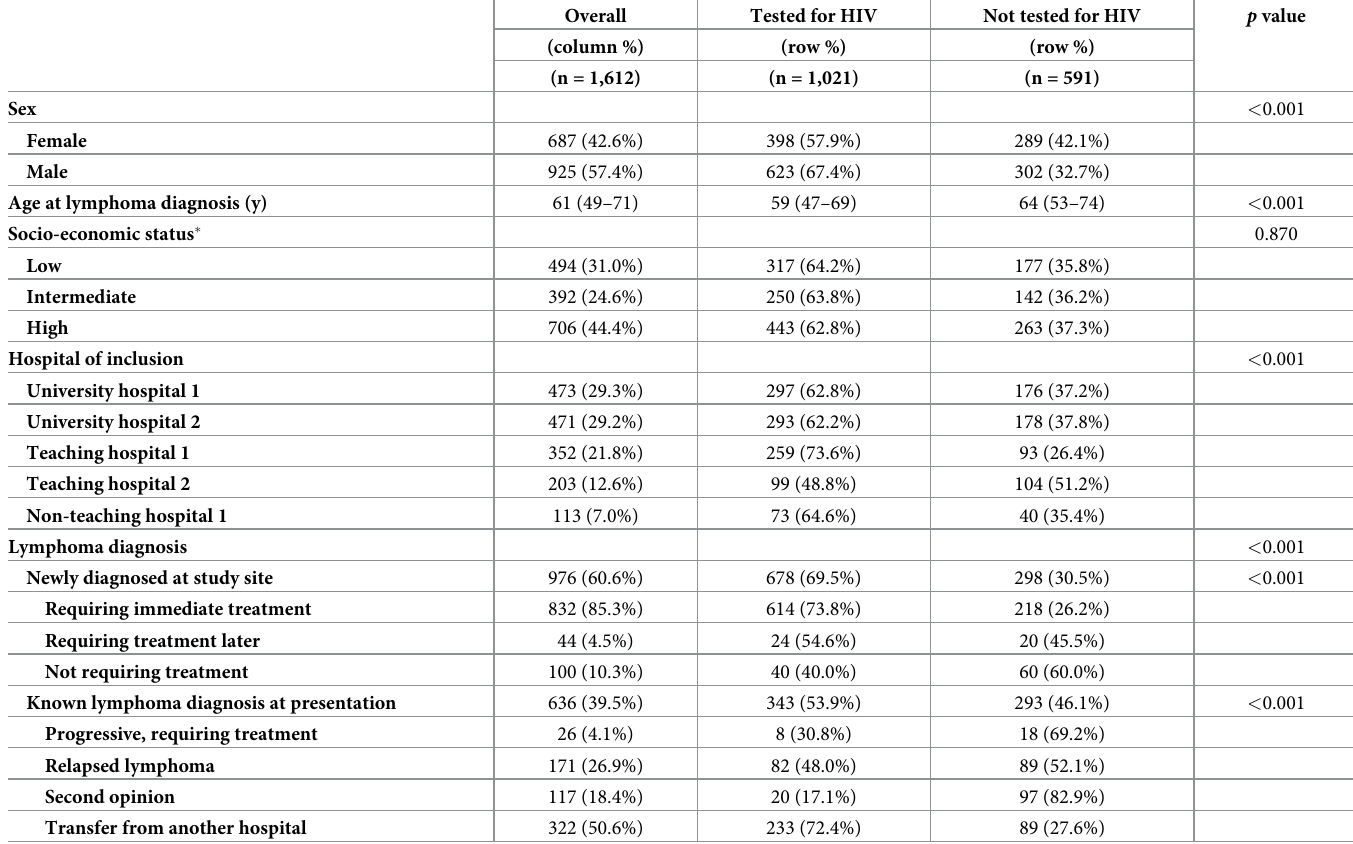
Table 1. Characteristics of included patients with malignant lymphoma in five hospitals in the region of Amsterdam, overall and by HIV testing within 3 months before and after malignant lymphoma diagnosis, treatment or work-up,